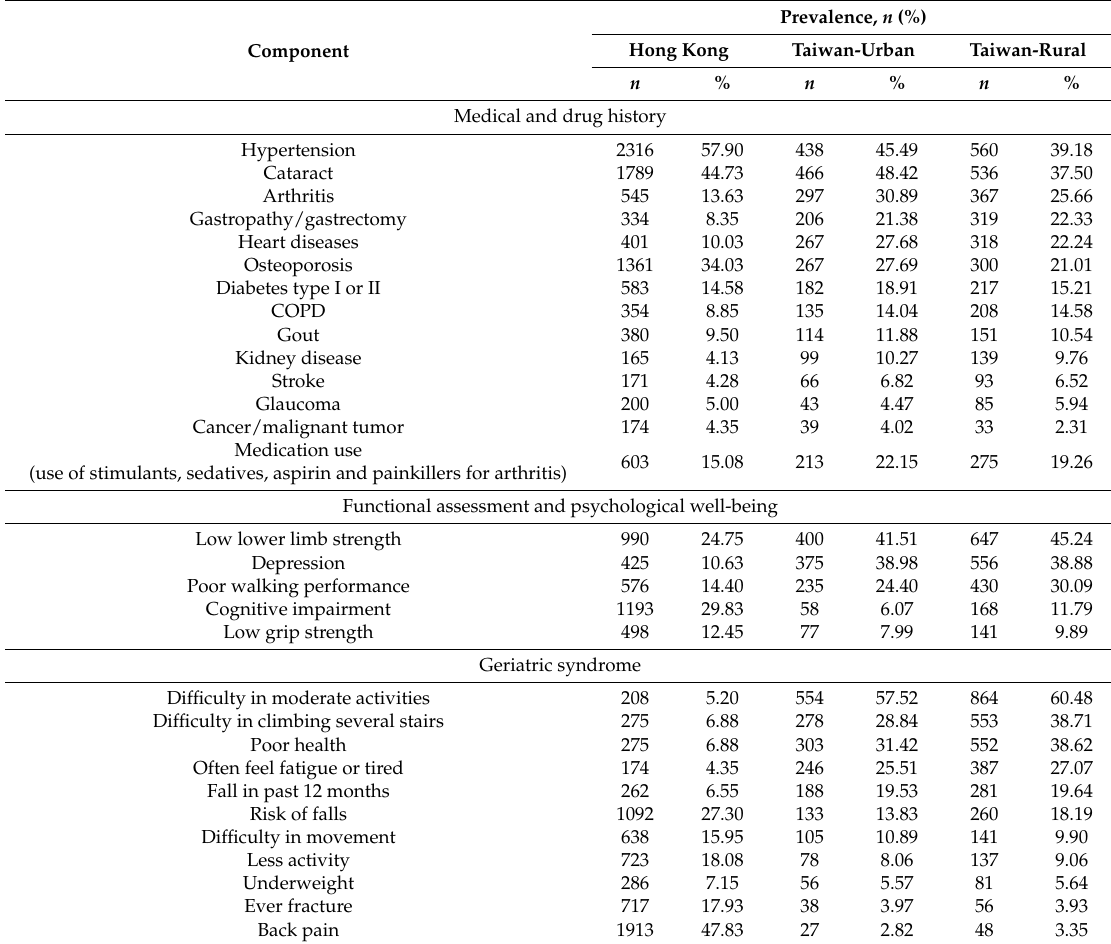
Table 1. Components of the frailty index.